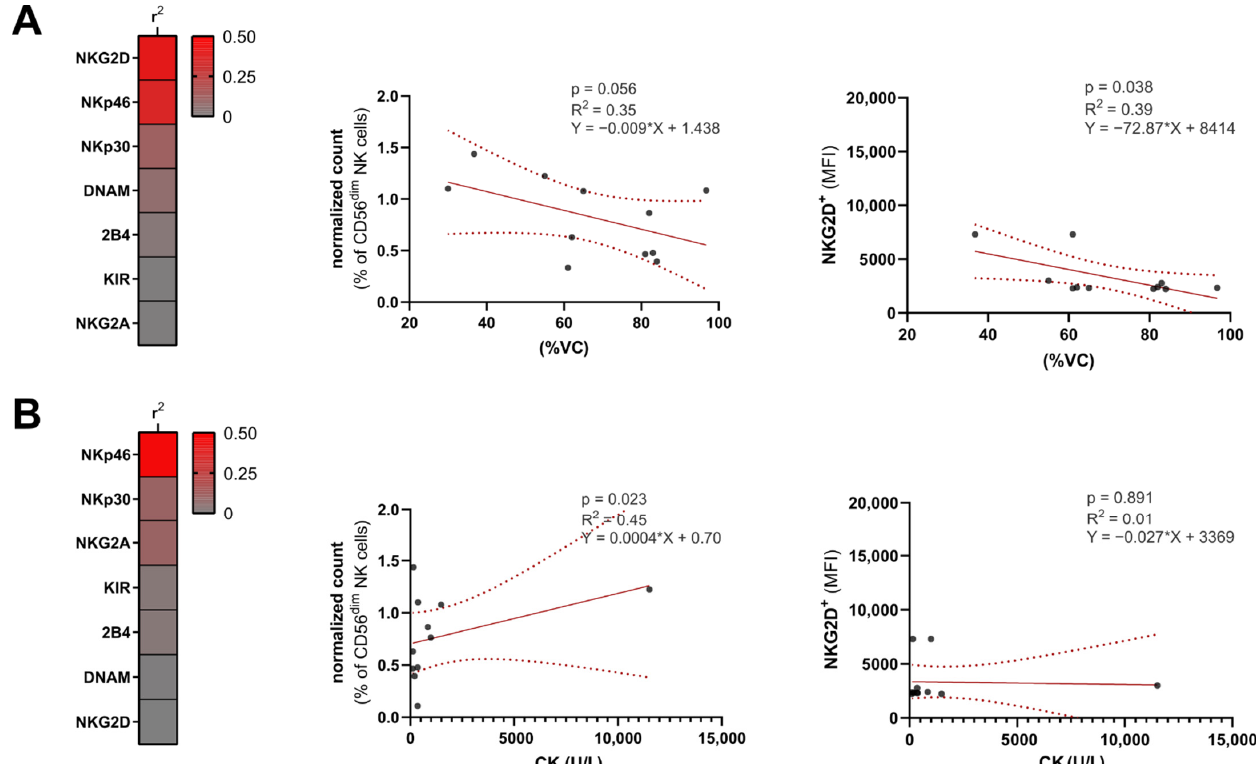
Figure 4. NK cell receptors are associated with severity of lung involvement. ( A ) Heatmap displaying R 2 values of a linear regression model with %VC serving as the dependent variable and NK cell receptors as the influencing variable. For regression analysis, relative cell numbers were used for NKp30 and Nkp46, as these receptors are constitutively expressed upon inflammatory stimulation. Linear regression displaying the correlation of NKp46 + and NKG2D + MFI with %VC, respectively. ( B ) Heatmap displaying R 2 values of a linear regression model with serum CK serving as the dependent variable and NK cell receptors as the influencing variable. Linear regression displaying correlation of NKp46 + and NKG2D + MFI with serum CK, respectively. Abbreviations: CK = creatine kinase, MFI = mean fluorescence intensity, NK = natural killer, %VC = percentage predicted vital capacity.